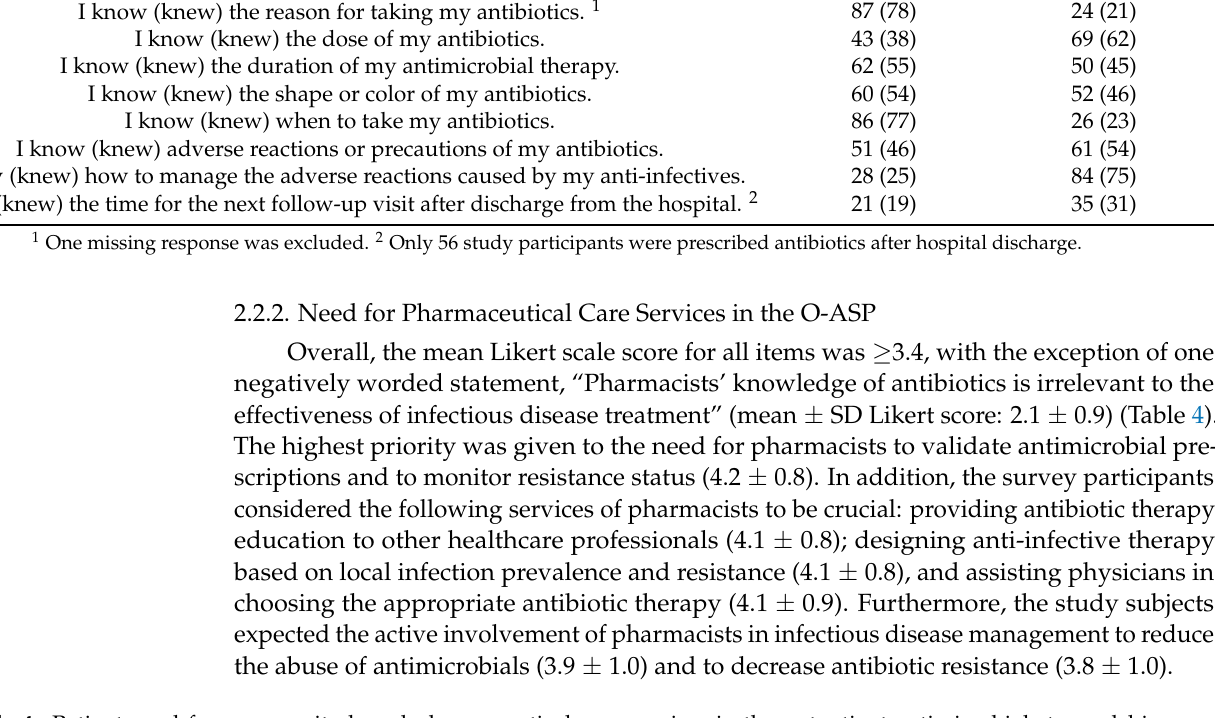
Table 4. Patient need for community-based pharmaceutical care services in the outpatient antimicrobial stewardship program ( n = 112); 5-point Likert scale from strongly disagree (1) to strongly agree (5). Statement The abuse of antimicrobials would be reduced by the active involvement of pharmacists in